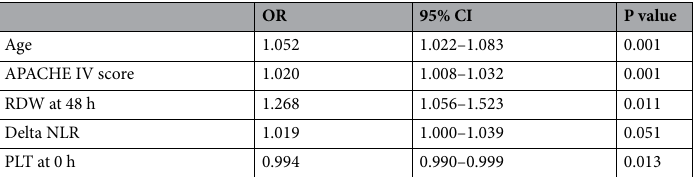
Table 4. Logistic regression analysis using backwards stepwise regression (likelihood ratio) for independent predictors of hospital mortality. (a) Factors included within the model building: Age, APACHE IV score, presence of chronic kidney disease, presence of haematological malignancy, presence of septic shock, use of mechanical ventilation, use of renal replacement therapy, lymphocytes at 0 h and 48 h, delta lymphocytes, monocytes at 48 h, platelets at 0 h and 48 h, delta platelets, the neutrophil lymphocyte ratio at 48 h, delta NLR, RDW at 0 h and 48 h (factor selection based on the univariate analysis results from Table 2 with P < 0.1 and without collinearity). (b) Logistic regression: Hosmer ‒ Lemeshow test chi-square 4.455, df 8, P = 0.814, AUROC of the model: 0.830, 95% CI